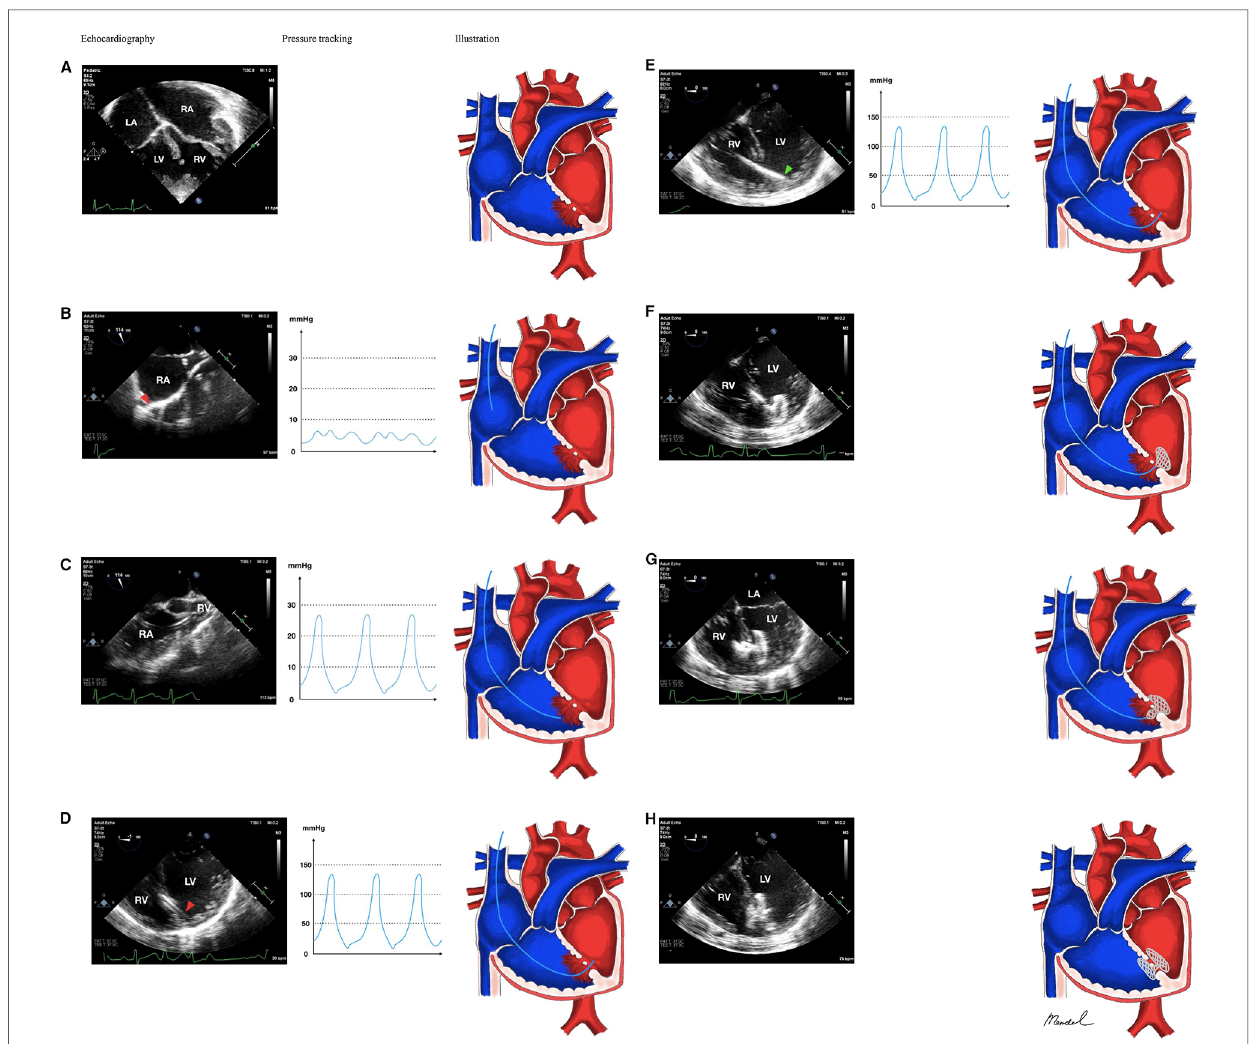
FIGURE 1 Antegrade jugular vein approach in multiple-defect muscular VSD closure with pulmonary hypertension. ( A ) Multiple VSD. ( B ) 5F sidehole Multipurpose catheter was directed from SVC towards RA. ( C ) Catheter was then directed towards RV. ( D ) The catheter successfully crossed from RV into LV. ( E ) With the assistance of 0.035 ″ Amplatzer stiff wire, the catheter was changed with 8F delivery sheath. ( F ) The Amplatzer device occluder (AGA) No 16 mm was delivered and one of the disc was deployed in the LV side, ( G ) and RV side. ( H ) Device stowed in place; Red arrowhead showed the position of the catheter, green arrowhead showed the position of the delivery sheath. Notes: VSD, ventricular septal defect; SVC, superior vena cava; RV, right ventricle; LV, left ventricle; RA, right atrium; LA, left atrium